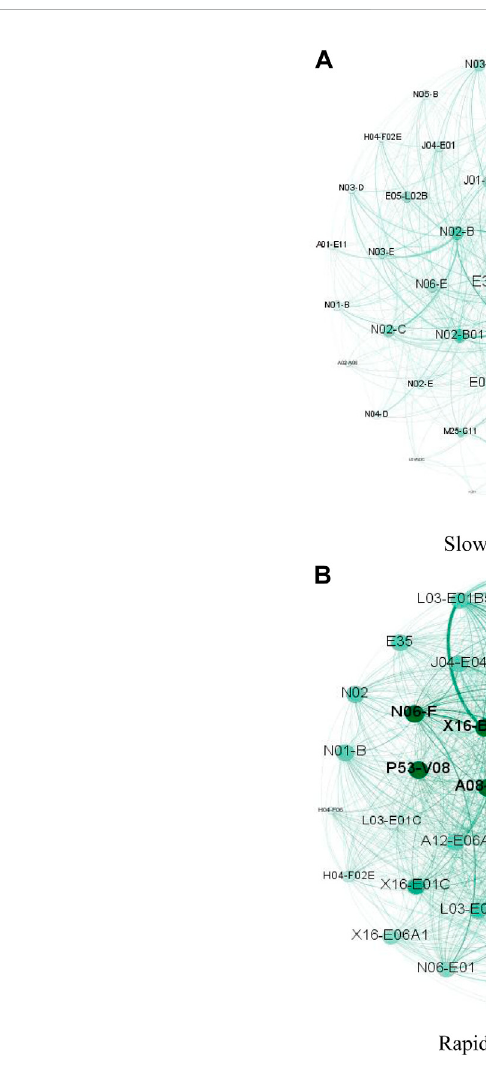
FIGURE 3 Identi fi cation of key cobalt technologies at different